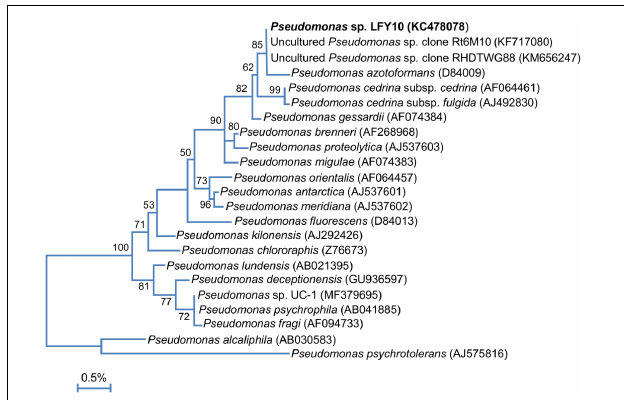
FIGURE 5 | 16S rRNA phylogenetic analysis of strain LFY10 and related Pseudomonas strains. 16S rRNA gene sequences from strain LFY10 and other Pseudomonas species were aligned using Muscle ( n = 1387 in final data set). The tree was constructed as for Figure 3 . GenBank accession numbers are shown in parentheses; type strains of each species were used unless otherwise noted. The scale bar indicates a distance equivalent to 0.5 nucleotide changes per 100 nucleotides.